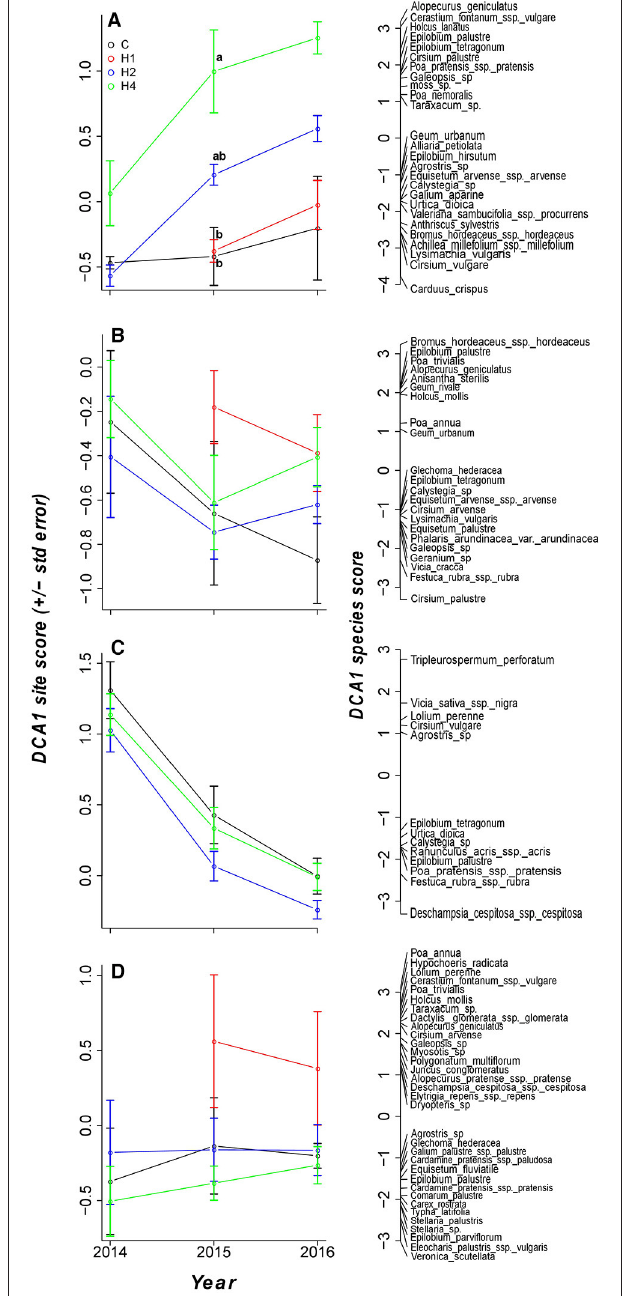
FIGURE 3 | Mean (standard error) of DCA 1 site scores of all vegetation types plotted over time with DCA1 species scores for each vegetation type. Treatment designation as in Figure 1 . Different letters indicate significant difference ( p < 0.05) tested by linear mixed effects model with post-hoc test for pairwise comparisons (for details, see Appendix Table 4 in Supplementary Material). Only species with scores < -1 or > 1 are plotted. (A) Tall herb fringe, (B) Tall grass community, (C) Ryegrass-dominated lower herb/grass community, (D) Rich fen/wet